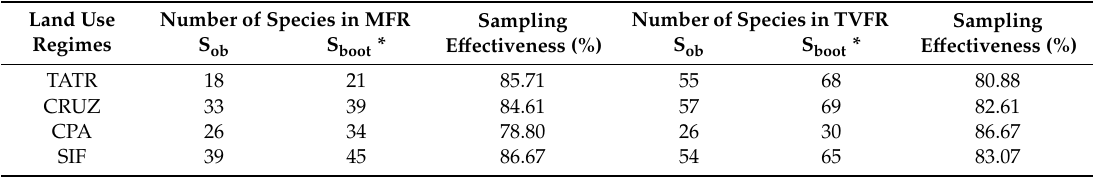
Table 1. Observed and estimated species number for land use regimes for MFR (Mafhela Forest Reserve) and TVFR (Thathe Vondo Forest Reserve).